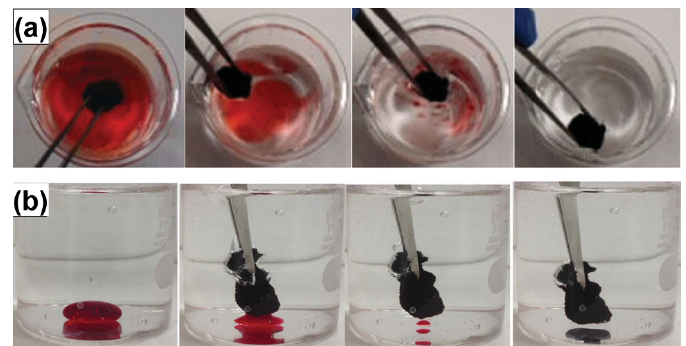
Figure 12. ( a ) Photographs showing the sorption process of heptane by using a TCF aerogel taken at intervals of 10 s. Heptane stained with Sudan red 5B floating on water was completely absorbed within 40 s. ( b ) Photographs showing the sorption process of chloroform by using a TCF aerogel. Chloroform stained with Sudan red 5B at the bottom of water was completely absorbed within 5 s. Reproduced with permission of Ref. [186] (Copyright Wiley-VCH Verlag GmbH & Co. 2014).